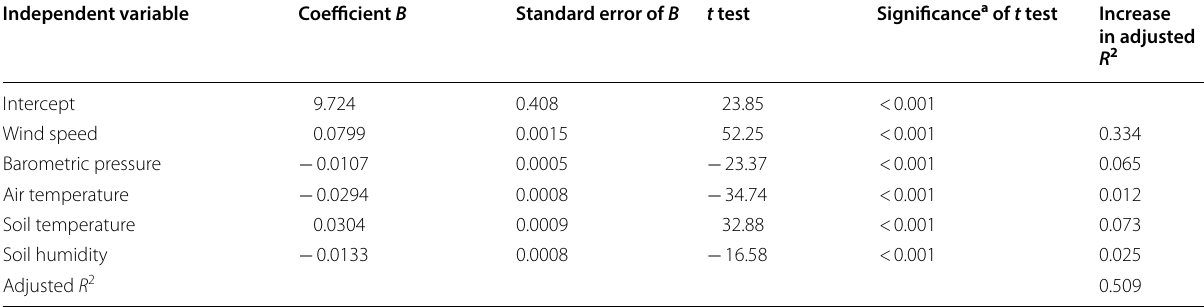
a Statistical significance of the correlation between each independent variable and dependent variable